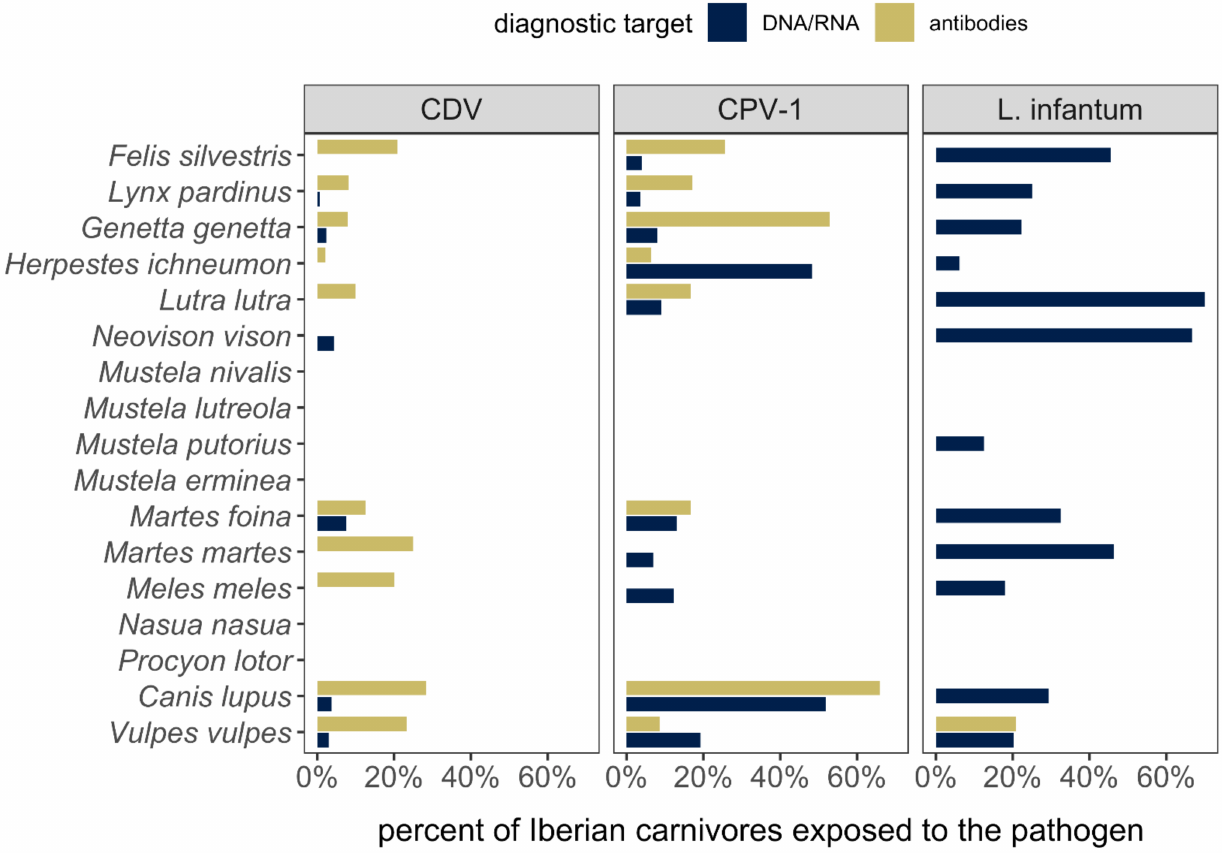
Figure 8. Percent of Iberian carnivores exposed to each of the three most frequently studied pathogens in Iberian carnivores (CDV, CPV-1, Leishmania infantum), stratified by each host species and diagnostic